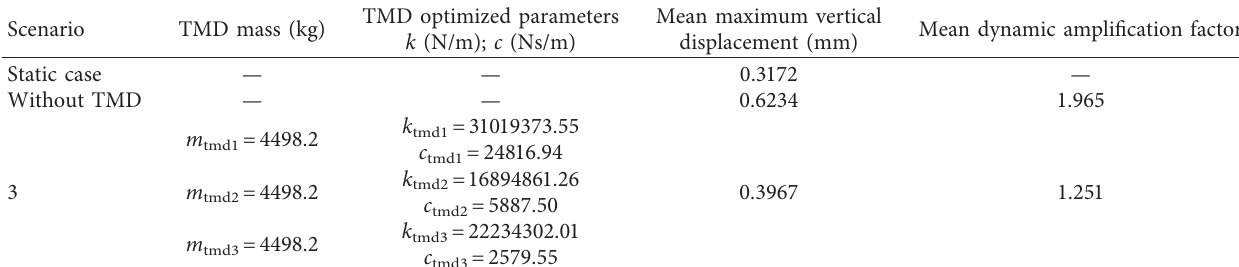
Table 5: Results of the proposed optimization procedure taking uncertainties into account.